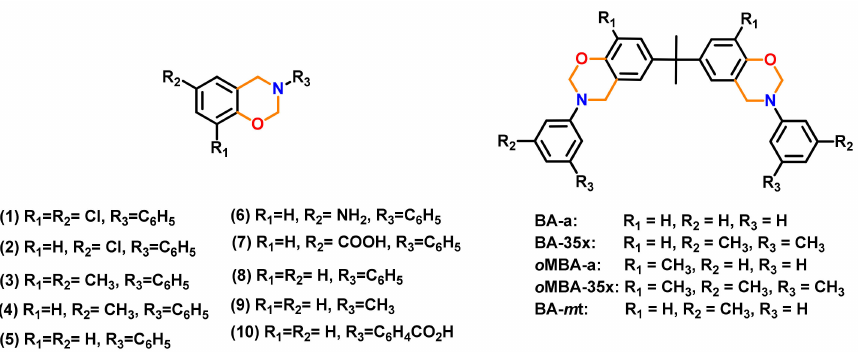
Figure 2. Representative mono- and bis-oxazine structures [82,83].